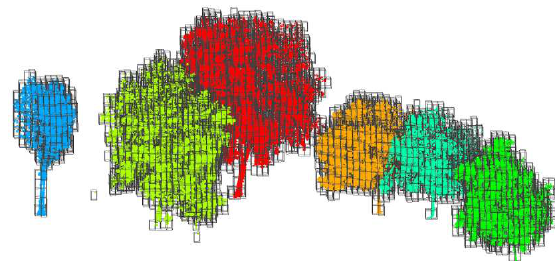
Figure 4. tree separation by the VoxTree algorithm (Image: Jinhu